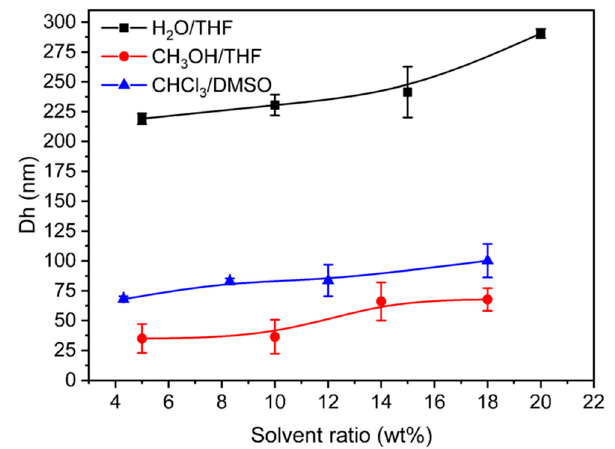
Figure 6. Hydrodynamic diameter of the block copolymer brush (sample 1) under selective solvent conditions as measured by dynamic light scattering (DLS). The solvent ratio indicates the proportion of the selective solvent (H 2 O, CH 3 OH, and CHCl 3 ).